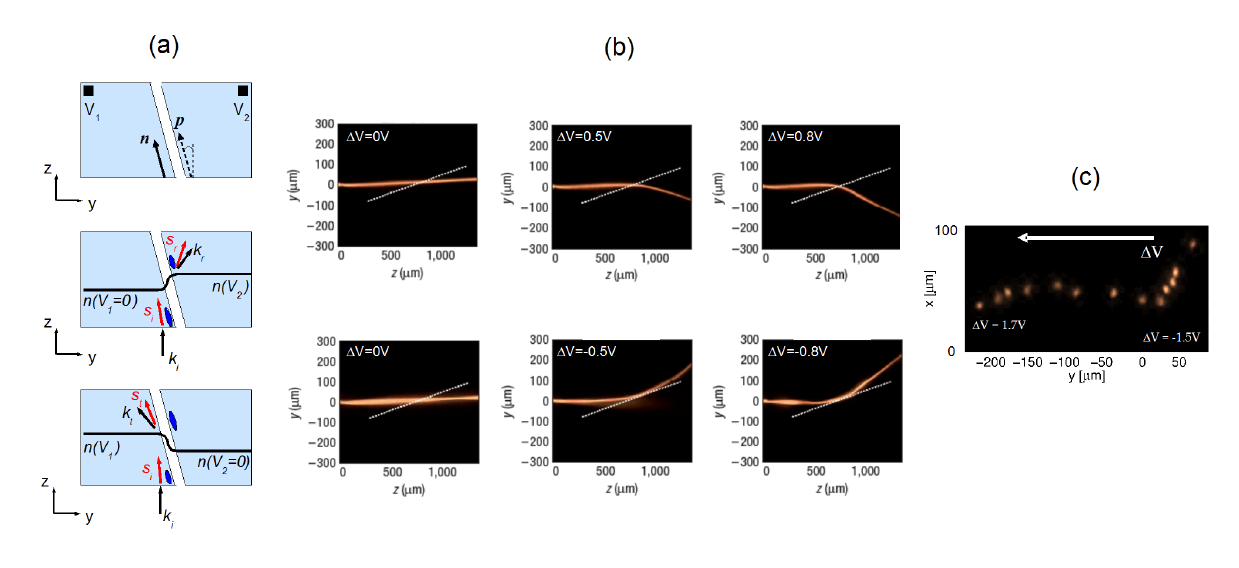
Figure 6. ( a ) Sketch of the sample with an electrically defined interface and interaction geometry: subscripts i , r and t label incident, refracted and reflected Poynting vectors ( s ) and wavevectors ( k ), respectively; ( b ) Acquired images of refraction ( top panels ) and total internal reflection (TIR) ( bottom ) for various ∆ V ; ( c ) Superposed photos of output beam profiles after 1 mm propagation; the white arrow indicates an increasing ∆ V